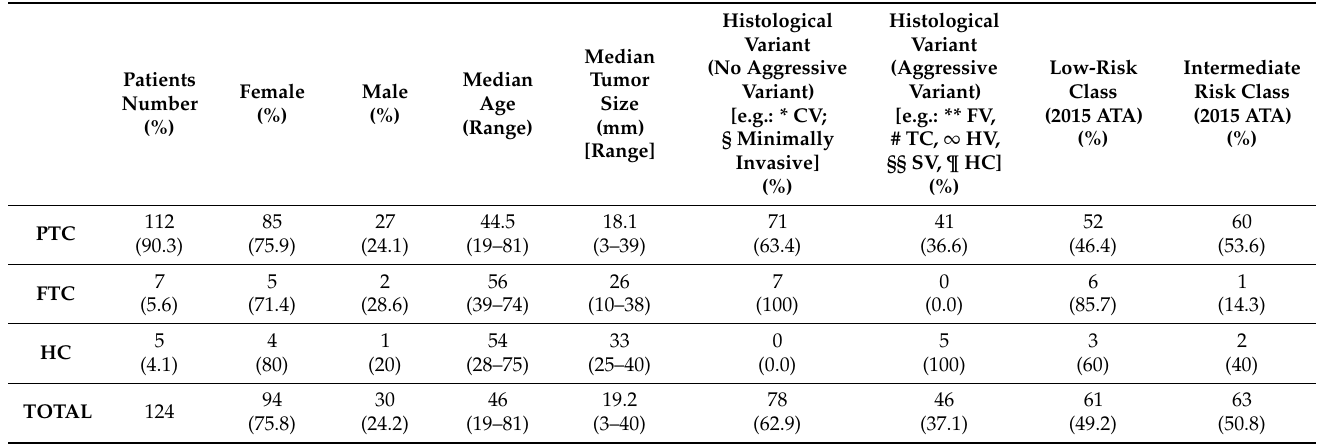
Table 1. Demographic, clinical and pathological data of the enrolled DTC patients.